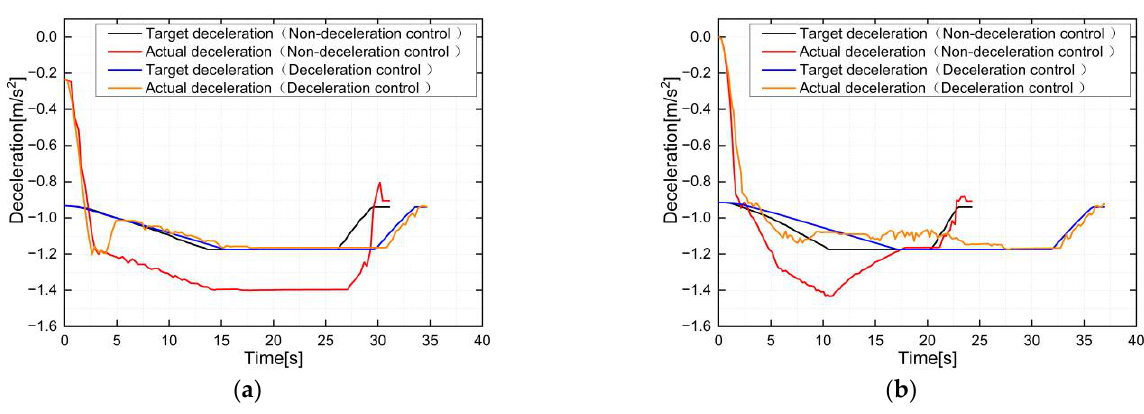
Figure 11. Test results with uncertain ramp gradient: ( a ) 25% gradient uphill ramp; ( b ) varying gradient ramp.